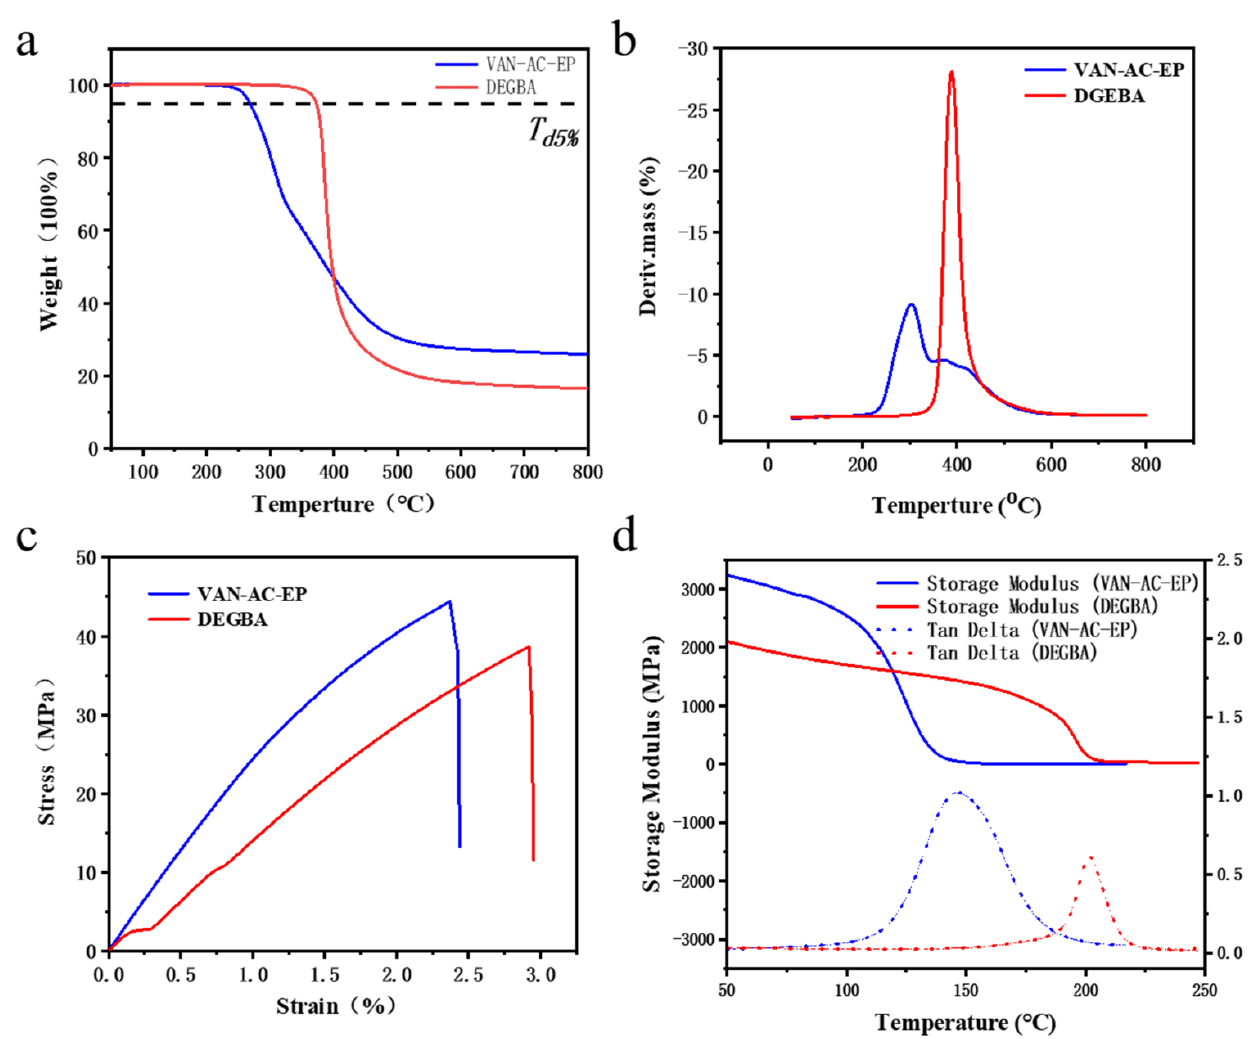
Figure 3. ( a ) TGA curves, ( b ) DTG curves, ( c ) stress–strain curves and ( d ) DMA curves of VAN-AC- EP/DDM and DGEBA/DDM. Table 2. Thermal performance of thermosetting resin.